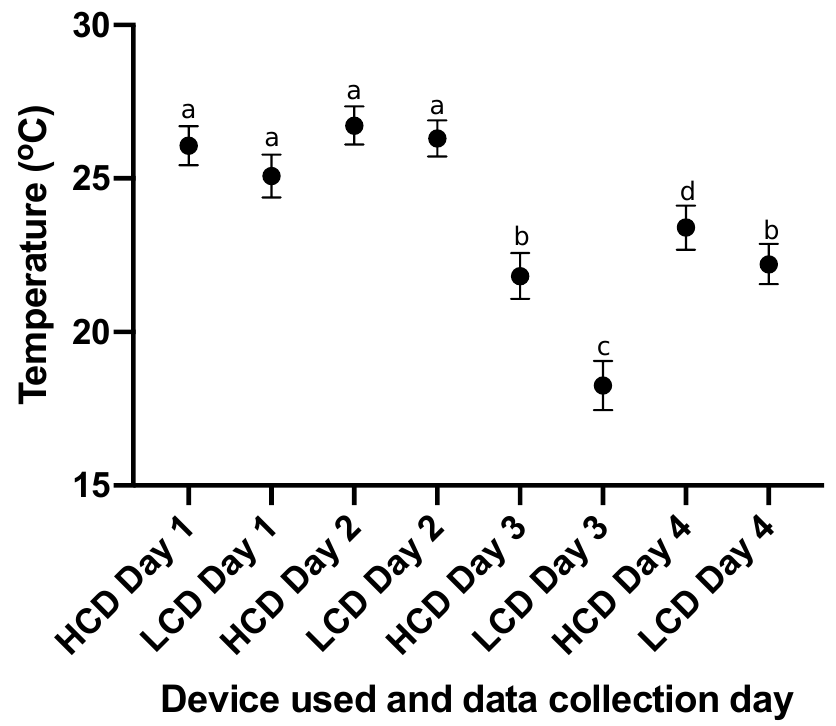
Figure 4. A graph showing the mean and 95% confidence interval of the maximum temperature of all cattle feet across each data collection day (n = 160, 164, 166, and 158 for data collection from each device on days 1–4, respectively) collected by the CAT S62-Pro Smartphone (LCD) and the FLIR T620bx (HCD). abcd different superscripts indicate significant differences between means at p < 0.05.